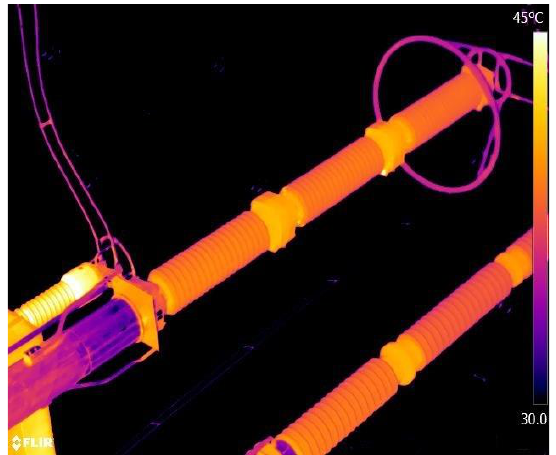
Figure 4. Thermal image of the surge arrester in the power substation.